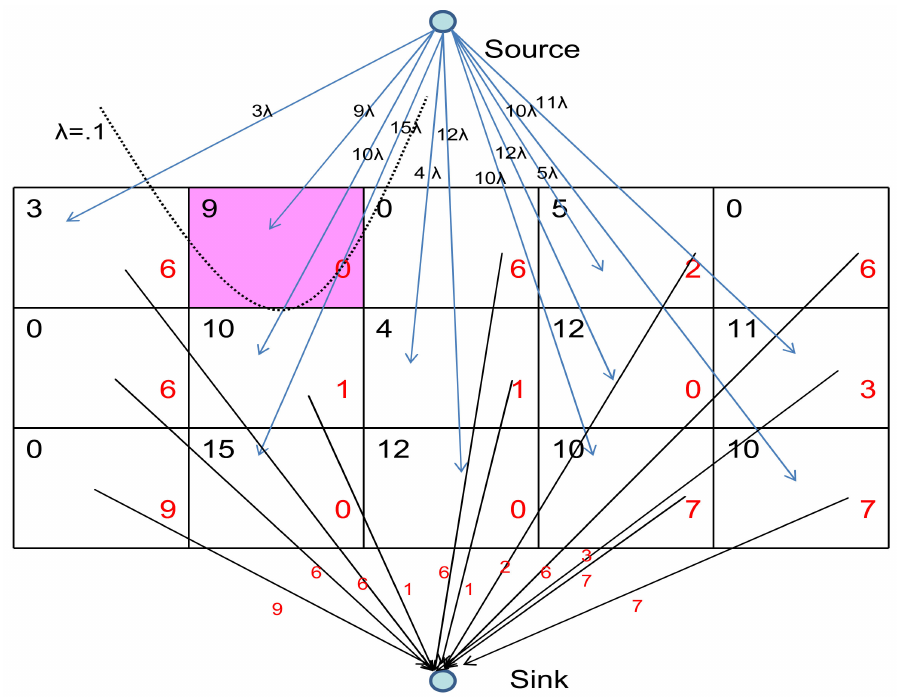
Figure 5. Parametric minimum-cut graph after multiplying λ with arcs from source to ore blocks. The first pushback is generated when the value of λ is